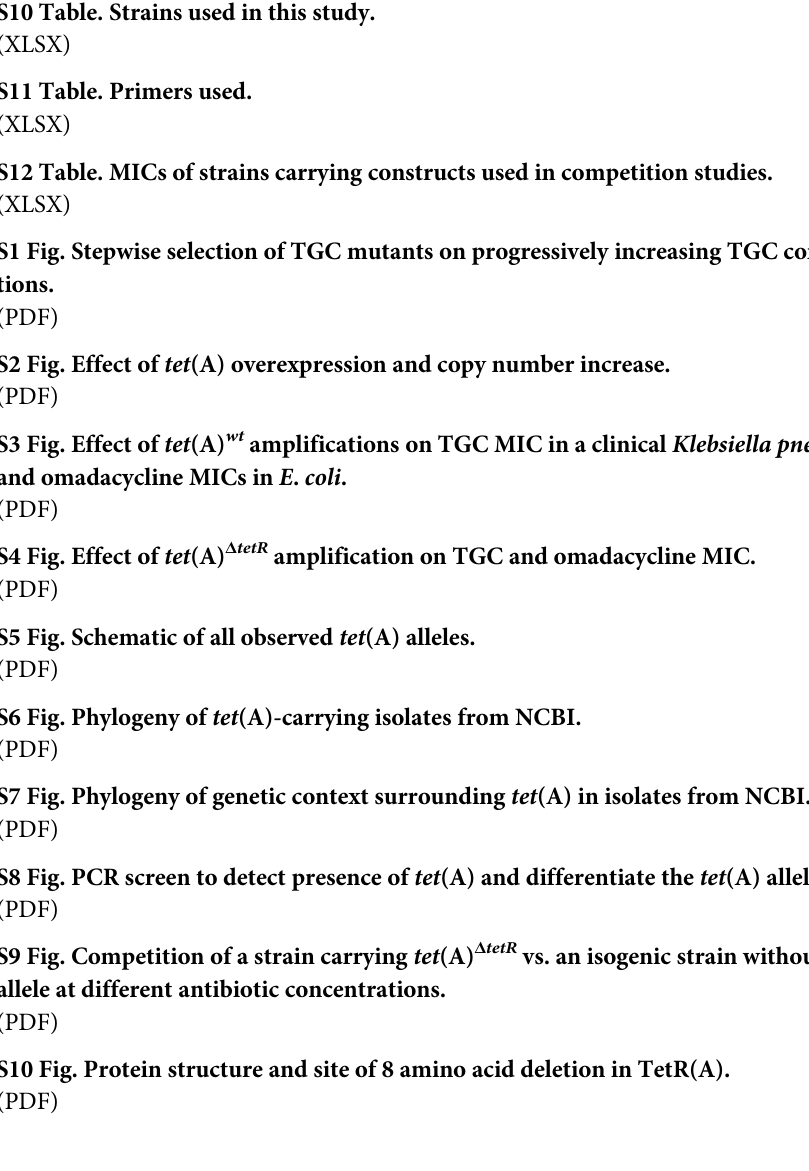
S5 Table. MICs of mutants and mutations found following selection of resistant mutants at TGC 0.5 mg/L. (XLSX) S6 Table. MICs of a subset of isolates. (XLSX) S7 Table. Effect of tet (A) alleles on TGC resistance development. (XLSX) S8 Table. Characterisation of tet (A)-carrying isolates from NCBI. (XLSX) S9 Table. Evolution of tet (A) experiments. (XLSX) S10 Table. Strains used in this study. (XLSX) S11 Table. Primers used. (XLSX) S12 Table. MICs of strains carrying constructs used in competition studies. (XLSX) S1 Fig. Stepwise selection of TGC mutants on progressively increasing TGC concentra- tions. (PDF) S2 Fig. Effect of tet (A) overexpression and copy number increase. (PDF) S3 Fig. Effect of tet (A) wt amplifications on TGC MIC in a clinical Klebsiella pneumoniae and omadacycline MICs in E . coli . (PDF) S4 Fig. Effect of tet (A) Δ tetR amplification on TGC and omadacycline MIC. (PDF) S5 Fig. Schematic of all observed tet (A) alleles. (PDF) S6 Fig. Phylogeny of tet (A)-carrying isolates from NCBI. (PDF) S7 Fig. Phylogeny of genetic context surrounding tet (A) in isolates from NCBI. (PDF) S8 Fig. PCR screen to detect presence of tet (A) and differentiate the tet (A) alleles. (PDF) S9 Fig. Competition of a strain carrying tet (A) Δ tetR vs. an isogenic strain without any tet (A) allele at different antibiotic concentrations. (PDF) S10 Fig. Protein structure and site of 8 amino acid deletion in TetR(A).